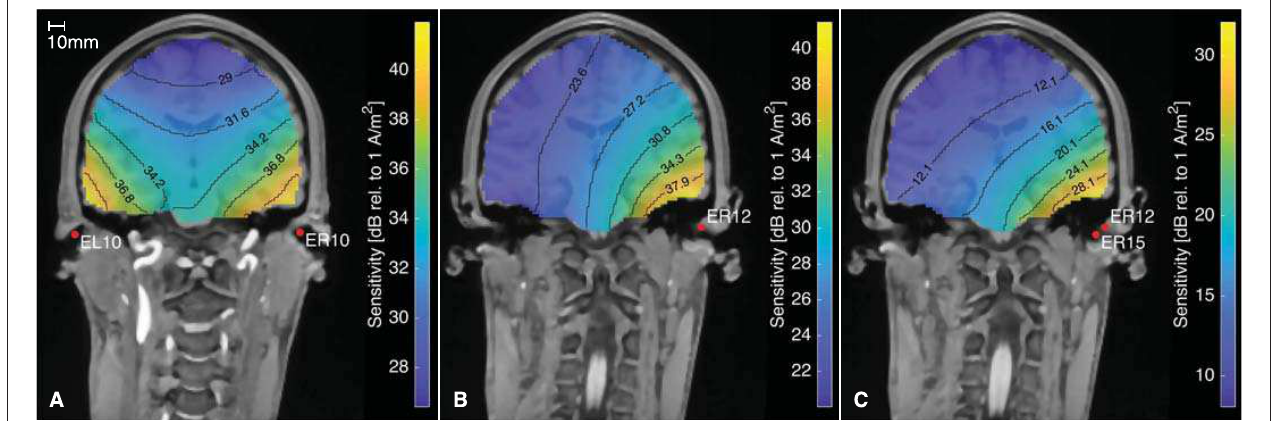
FIGURE 11 | The sensitivity distribution for different electrode configurations, based on an ear-EEG forward model for Subject C. (A) Between-ears electrode configuration, (B) Ear electrode to an infinite reference, (C) Within-ear electrode configuration.